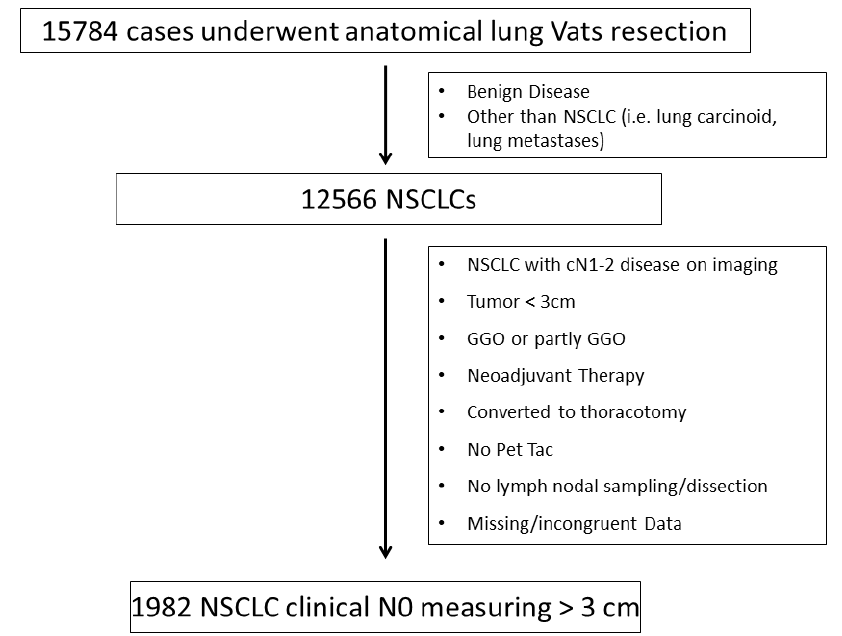
Figure 1. Consort